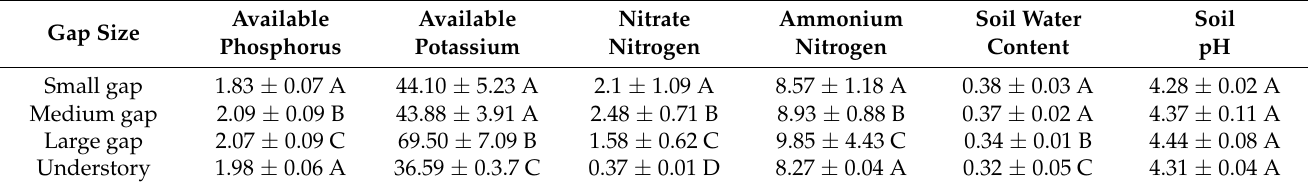
Table 4. Effect of different sizes of forest gaps on soil chemical properties (mean ± SE, 95% CI).